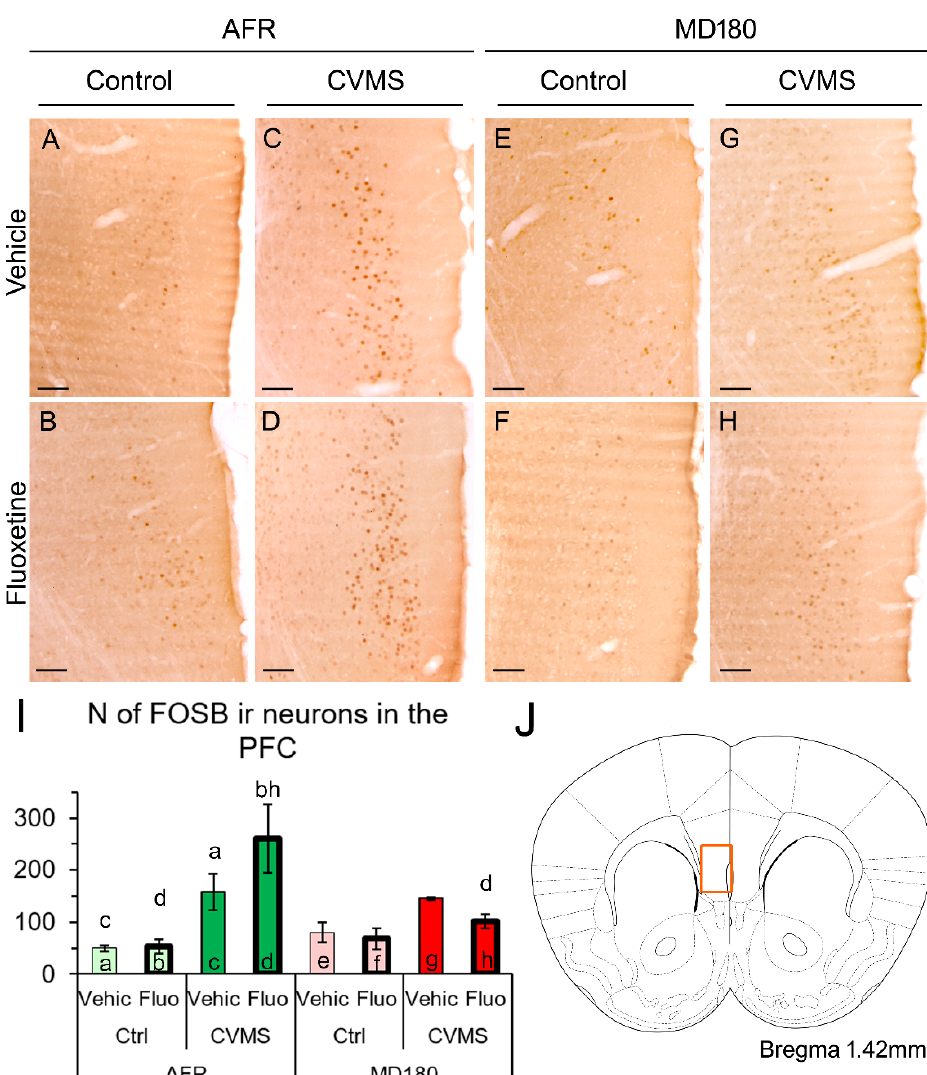
Figure 3. FOSB immunoreactivity (ir) in the prefrontal cortex (PFC). Representative images illustrate FOSB-ir in the PFC of vehicle (Vehic) ( A ) and fluoxetine (Fluo)-treated ( B ) control (Ctrl) as well as chronic variable mild stress-exposed (CVMS) and vehicle- ( C ) or fluoxetine-injected AFR mice. History of maternal deprivation (MD180) affected the FOSB-ir in the respective groups, as illustrated by images ( E – H ). The imaged area shown in ( A – H ) corresponds to the highlighted region of PFC in ( J ) (scheme modified after Paxinos and Franklin [62]). Histogram ( I ) illustrates the count of FOSB-ir cell nuclei. Lettering indicates the most relevant significant differences between pairs of groups, according to the post hoc tests (n = 4–6). AFR: animal facility rearing. Bars: 100 µ